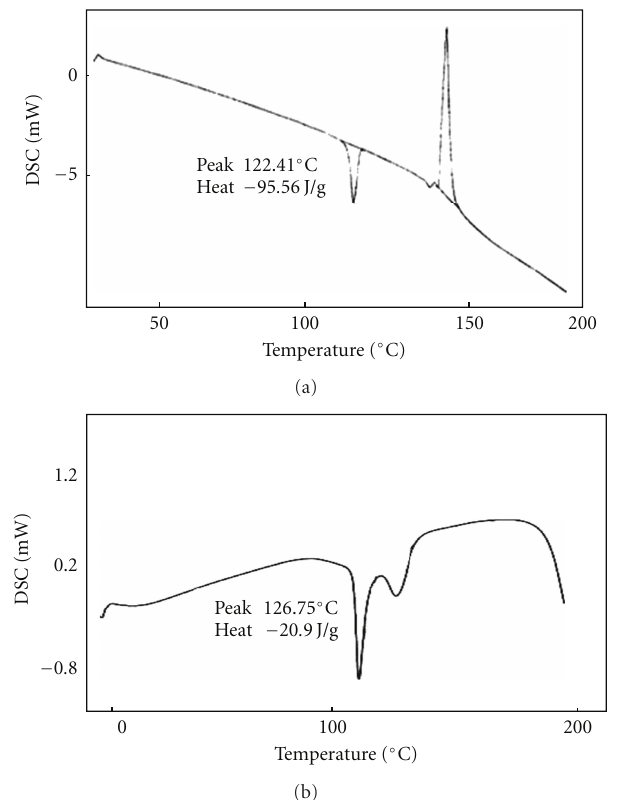
Figure 4: DSC profile of Topiramate drug substance (a), Topamax tablet (b).